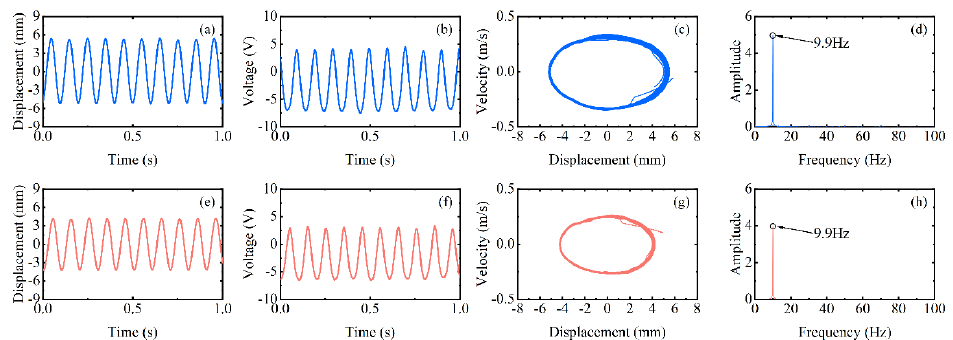
Figure 7. Experimental results of the inverse beam at 400 rpm (blue line) and 600 rpm (red line), ( a , e ) are the corresponding measured displacements, ( b , f ) are the corresponding measured output voltages, ( c , g ) are the displacement-velocity phase portrait, and ( d , h ) are the corresponding power spectrums.